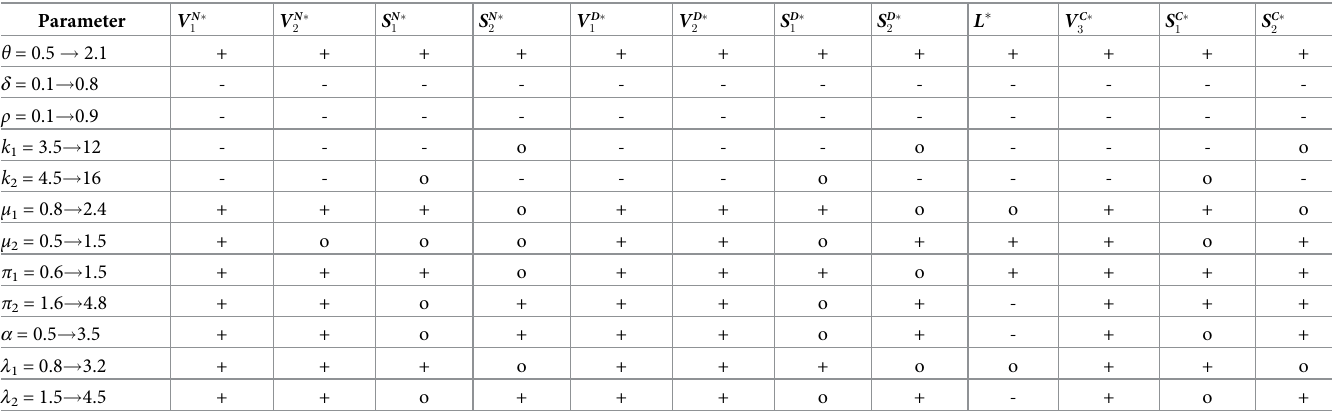
Table 2. Sensitivity analysis of relevant